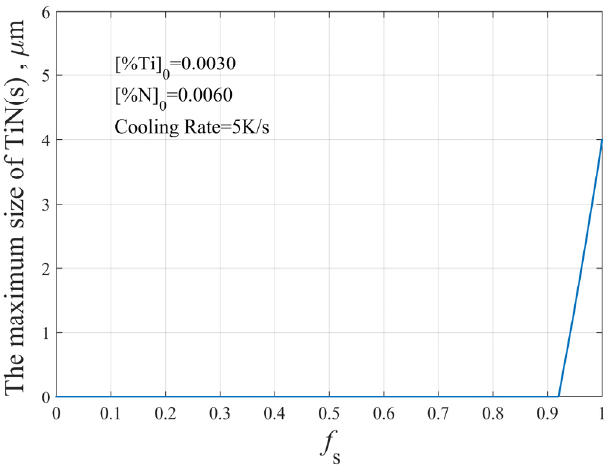
Figure 9. The theoretical maximum size of TiN inclusions at the end of solidification.